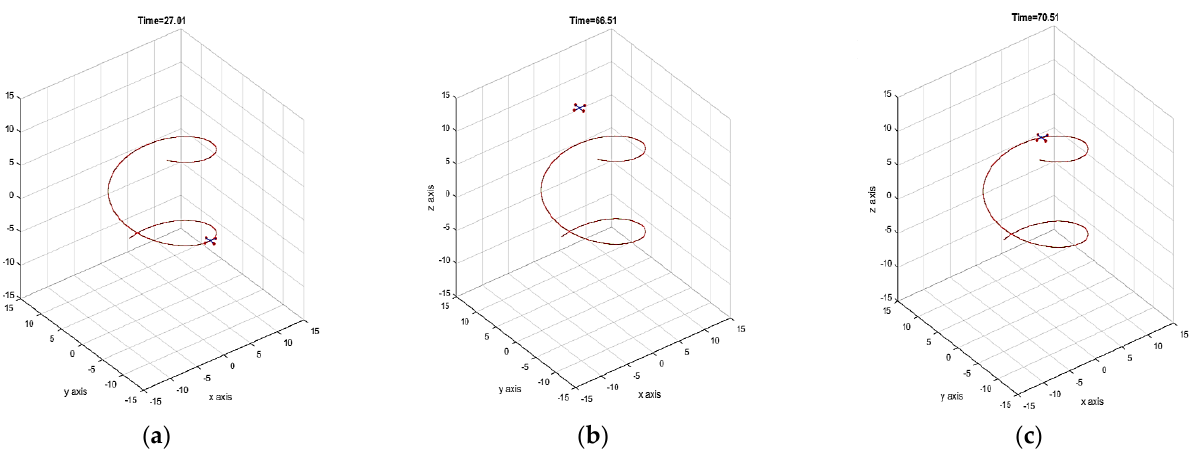
Figure 9. Quadrotor deviates from trajectory due to unmodelled dynamic factors.